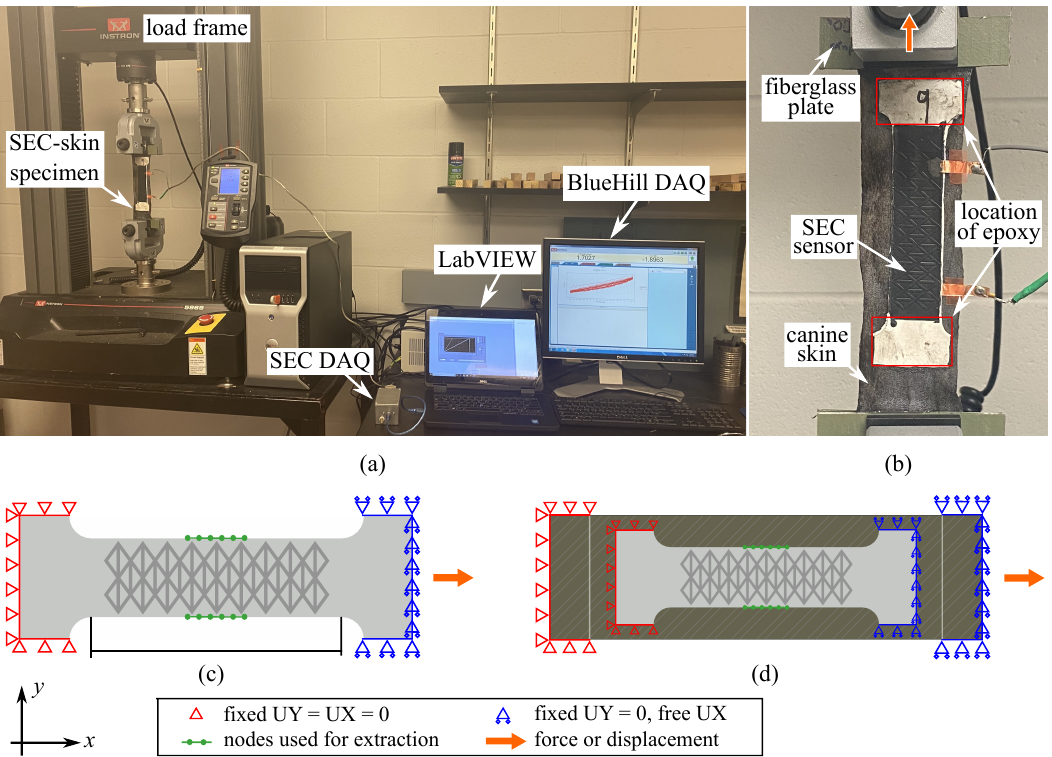
Figure 4. ( a ) Experimental set-up for the SEC-animal skin specimen; ( b ) zoom on the SEC-animal skin specimen showing the loading direction; and ( c ) schematic of the numerical model of the SEC and ( d ) SEC-canine skin showing the boundary conditions, nodes used for synthetic measurements, and loading